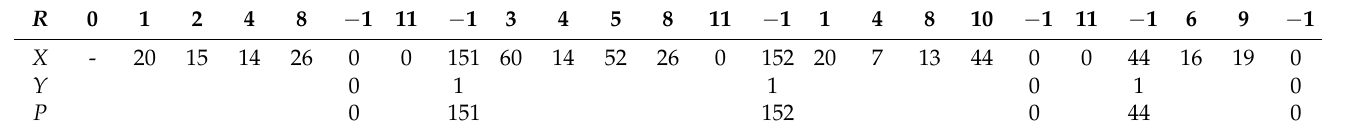
Table 9. Correction for i = 8 in C .